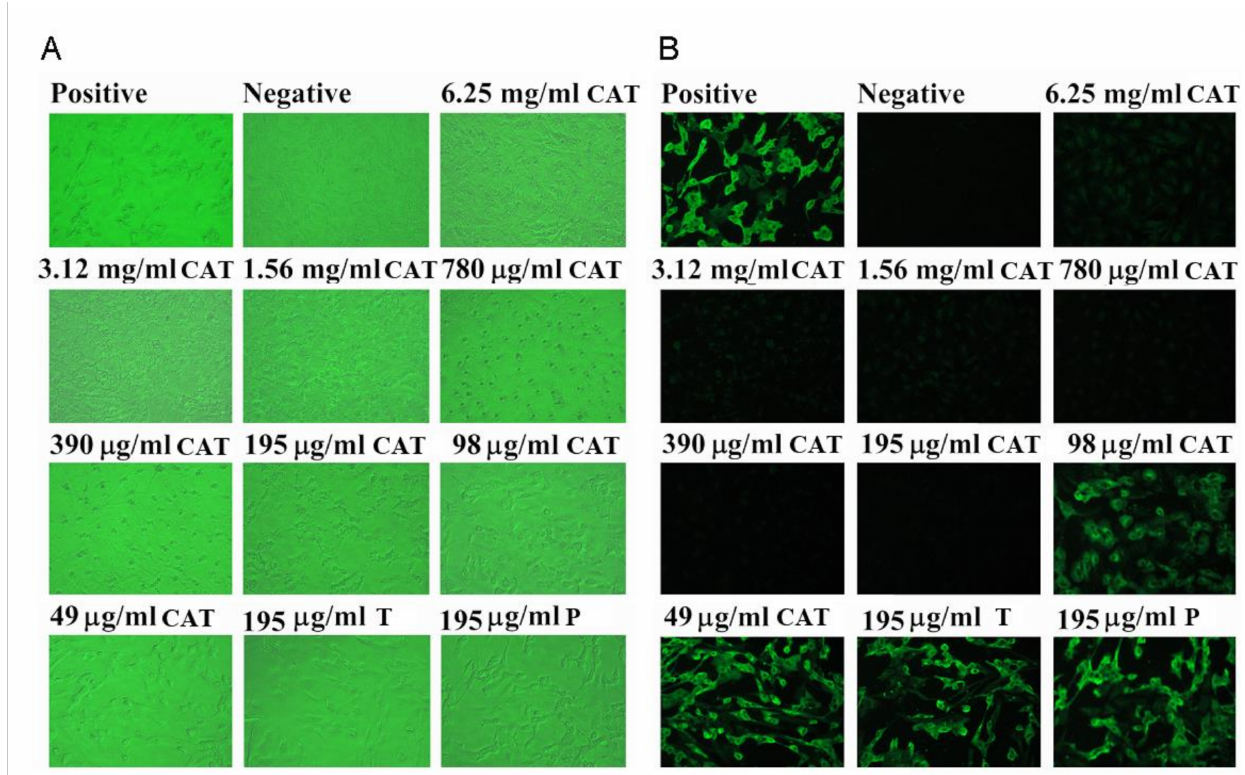
Figure 2. The dose effect of green tea extracts catechins on the morphologic alteration in SARS-CoV-infected Vero E6 cells ( A ). Vero E6 cells were treated with different concentrations of catechins, and the cell morphology was determined at 48 h post-infection. Vero E6 cells were normally expressed in the medium with catechins (6.25 mg–195 µ g) treatment, however, the infected Vero E6 cells without catechins treatment died and floated in the medium. The positive panel shows cells infected by SARS-CoV without catechins treatment; while the negative panel shows cells without virus infection. The dose effect of catechins on inhibiting viral antigen synthesis in SARS-CoV-infected Vero E6 cells ( B ). Vero E6 cells were treated with several concentrations of catechins, and an IFA was examined at 48 h post-infection. Viral antigen synthesis was partial blocked at 98 µ g/mL of catechins and completely blocked > 195 µ g/mL of catechins. The same dose of 195 µ g/mL tannin or procyanidin could not inhibit viral synthesis. The positive panel displays the cells infected by SARS-CoV without catechins treatment; whereas the negative panel displays the cells without SARS-CoV infection. T, tannin; P,